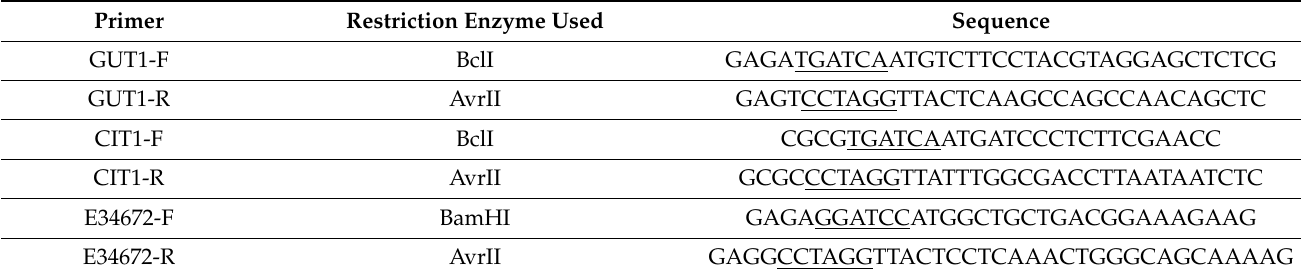
Table 8. Restriction enzymes used for plasmid